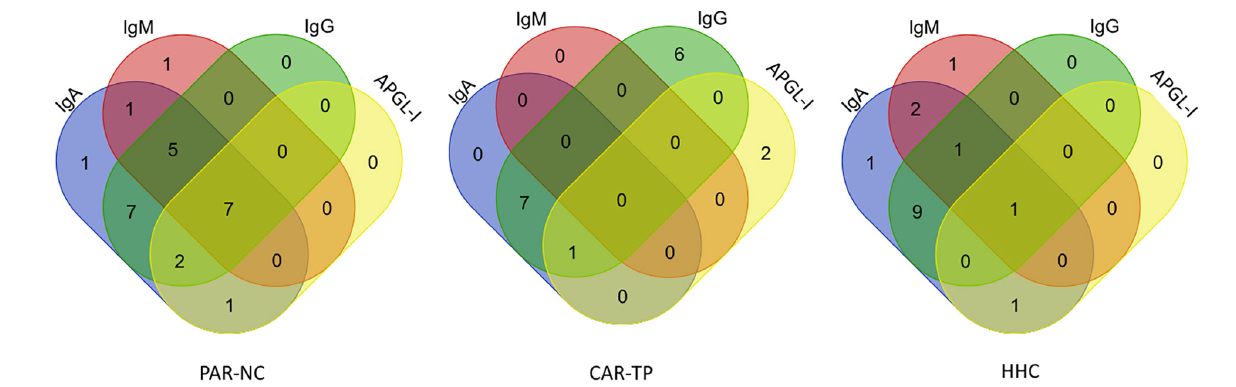
FIGURE 3 | Seropositivity pattern of antibodies in HD. The Venn diagrams represent the overlap in the number of positive IgA, IgM, IgG anti-Mce1A, and APGL-I antibodies in each of the comparison groups new cases of HD in Parnaíba (PAR-NC), treated HD patients in Colony Carpina (CAR-TP) and household contacts of HD patients in Parnaíba